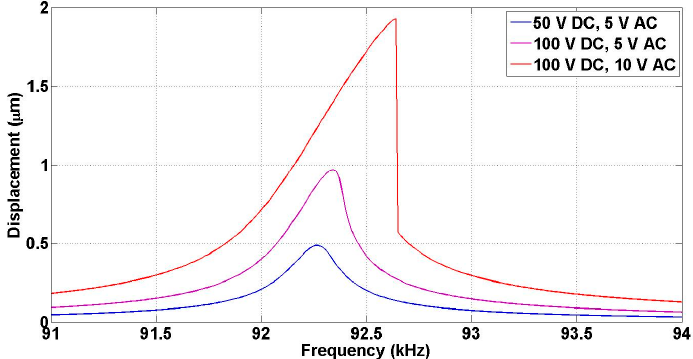
Figure 5. Frequency response of the non-linear MEMS actuator system for different applied voltages.